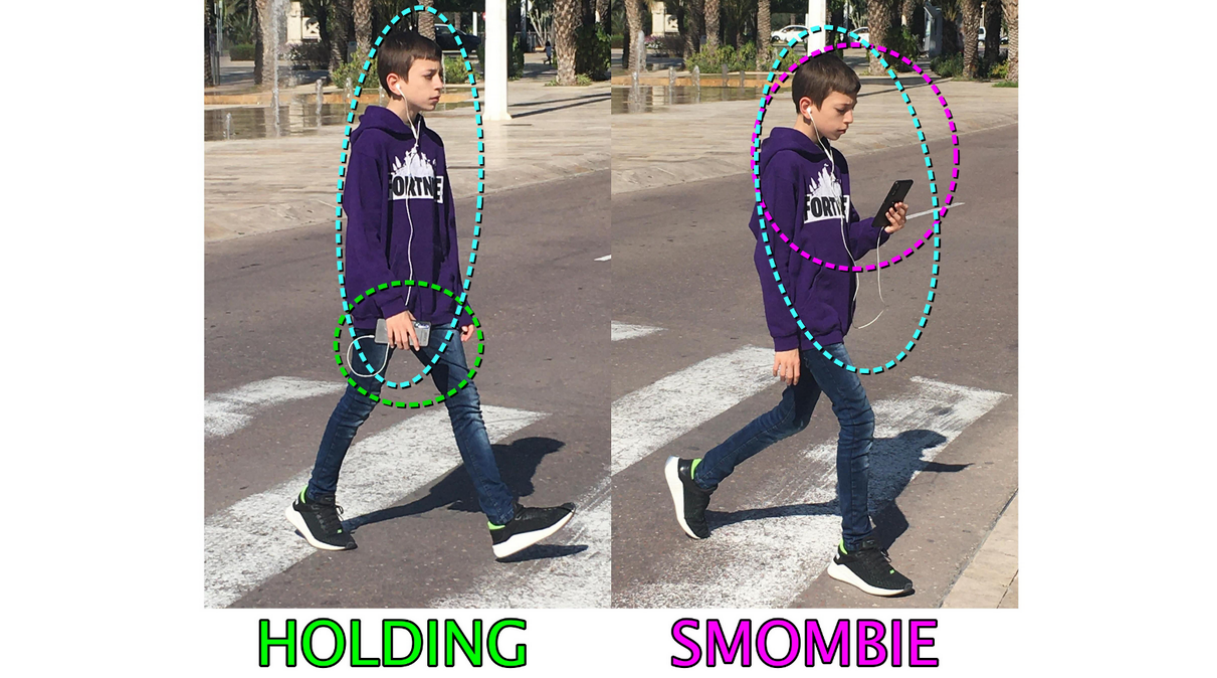
Figure 3. In pedestrians with mixed behavior, higher problematic smartphone usage was selected as the pedestrian